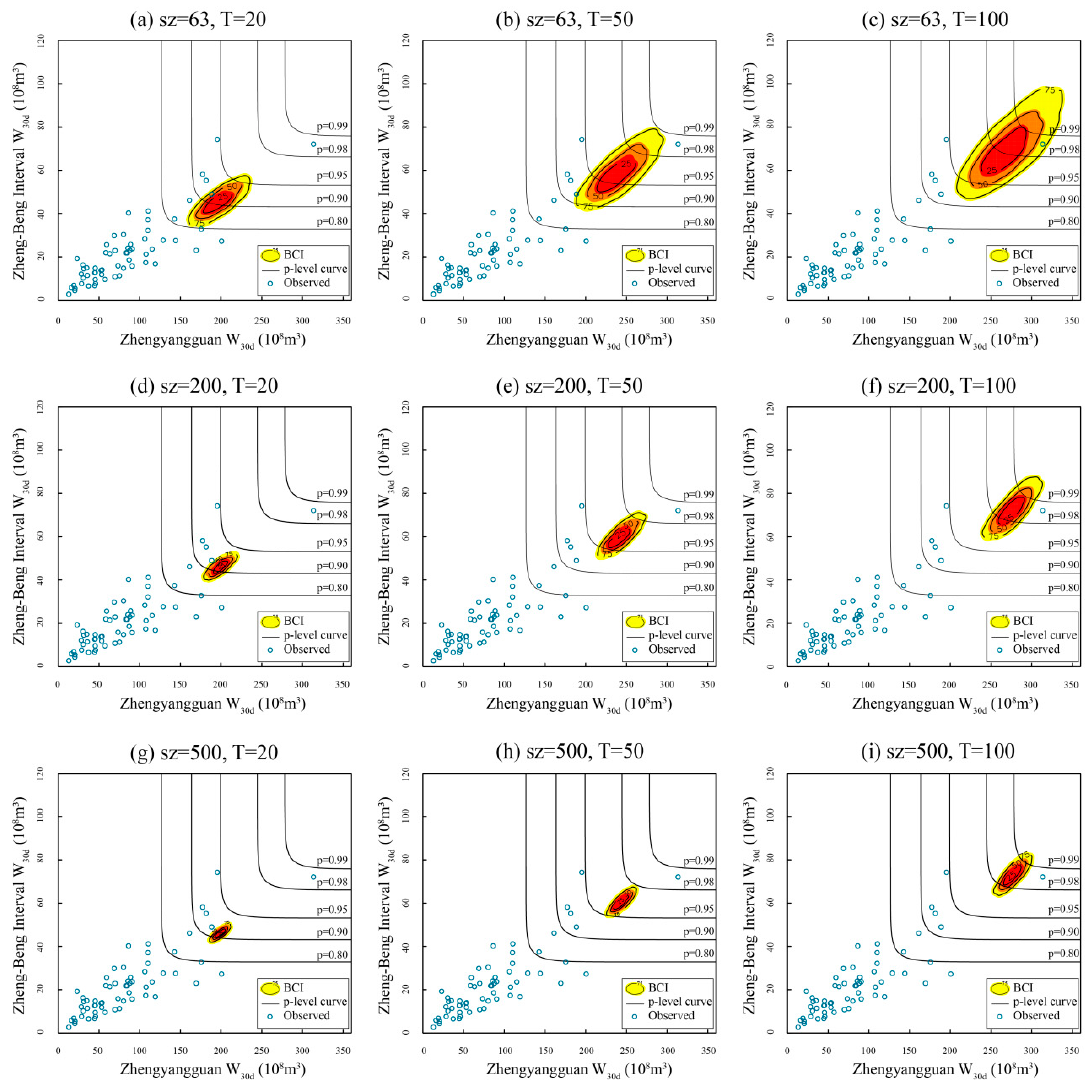
Figure 9. Comparison of CMLC realizations under different schemes when the designed values occur in the Zhengyangguan section.